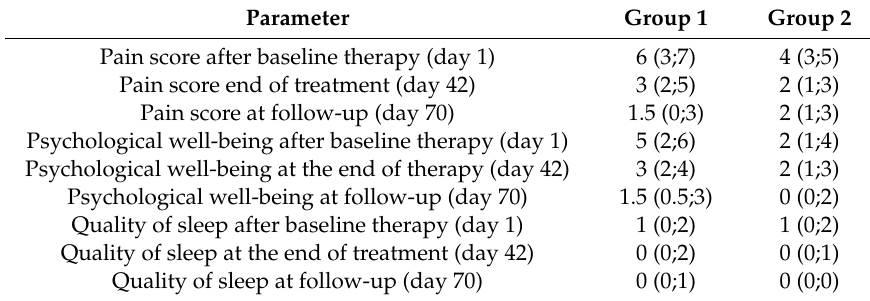
Table 2. Pain scores, psychological well-being and quality of sleep after baseline therapy, at the end of the active study period and at